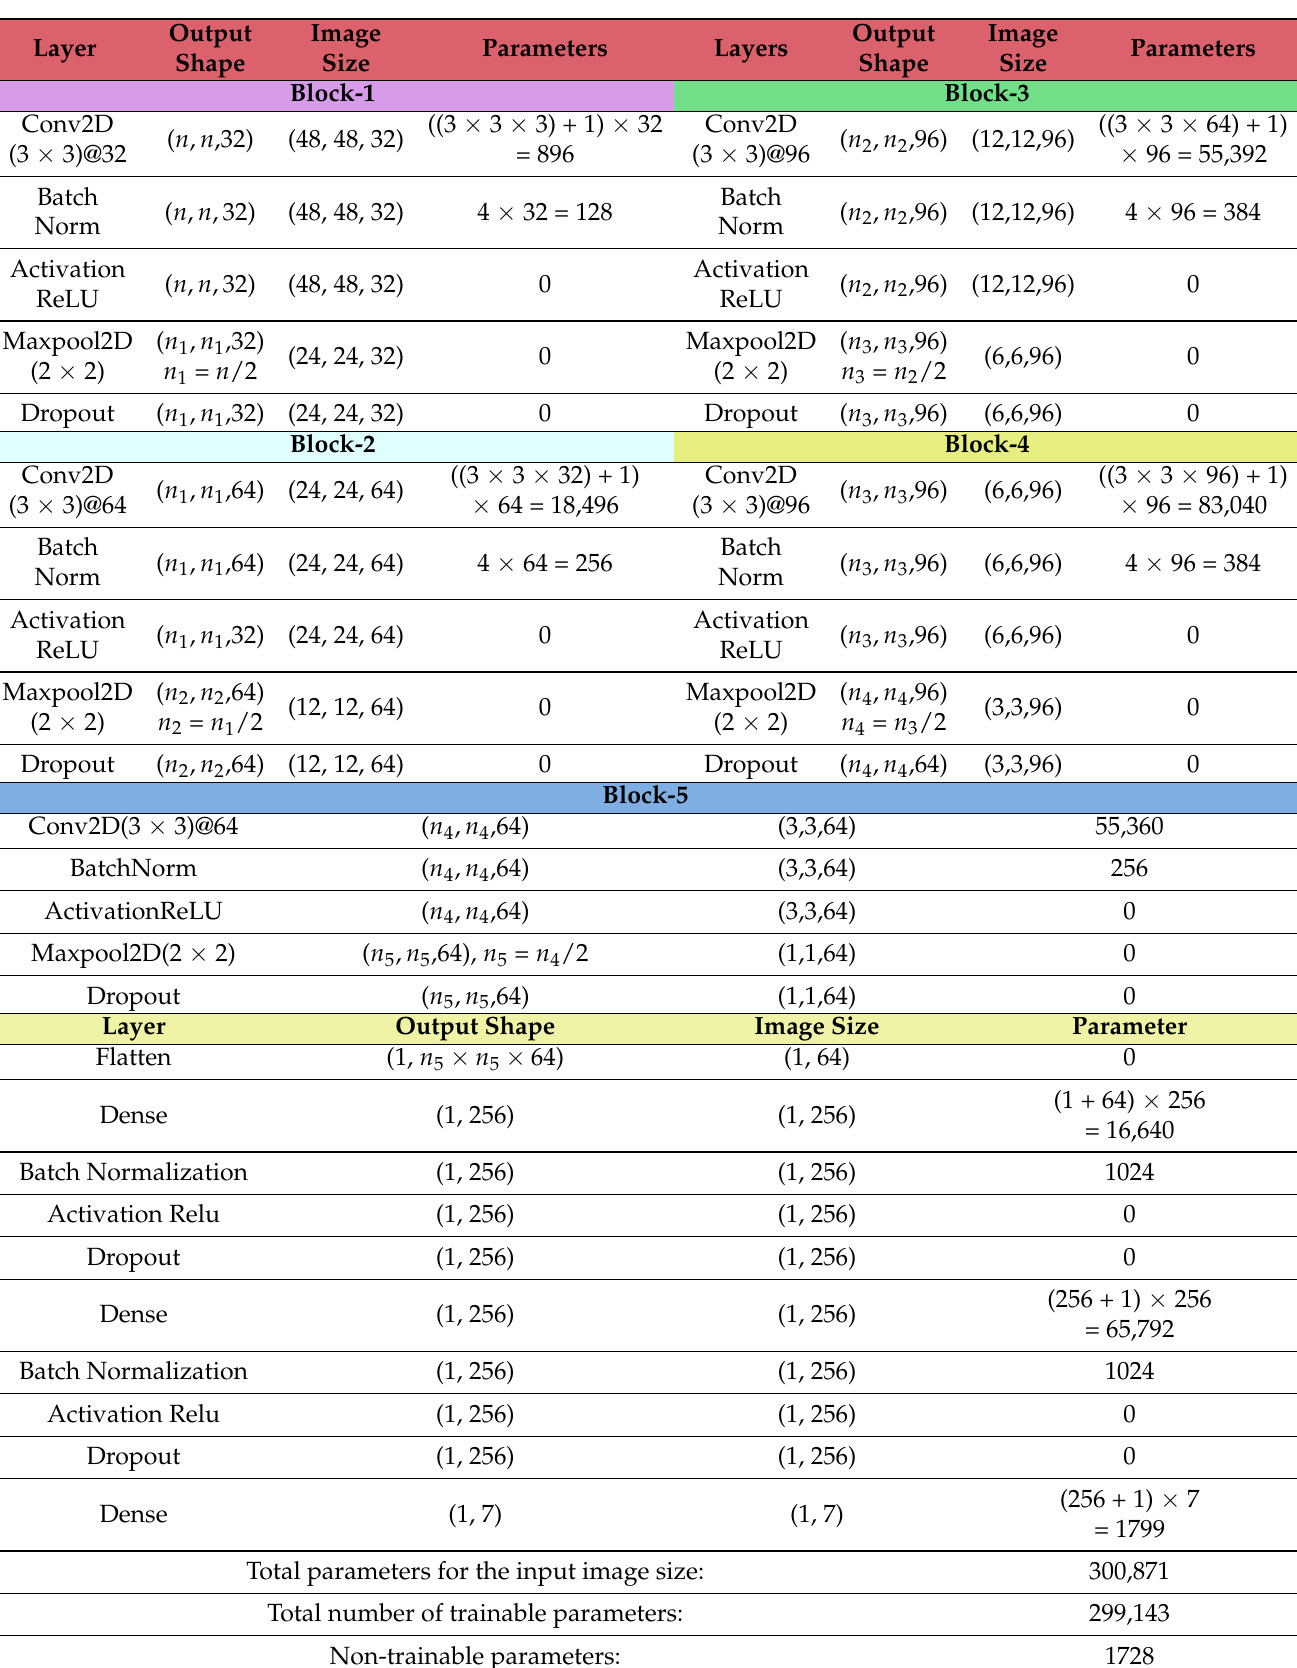
Table 1. The proposed CNN architecture for the input size 48 × 48 with layers, output shape, image size, and parameters. Layer